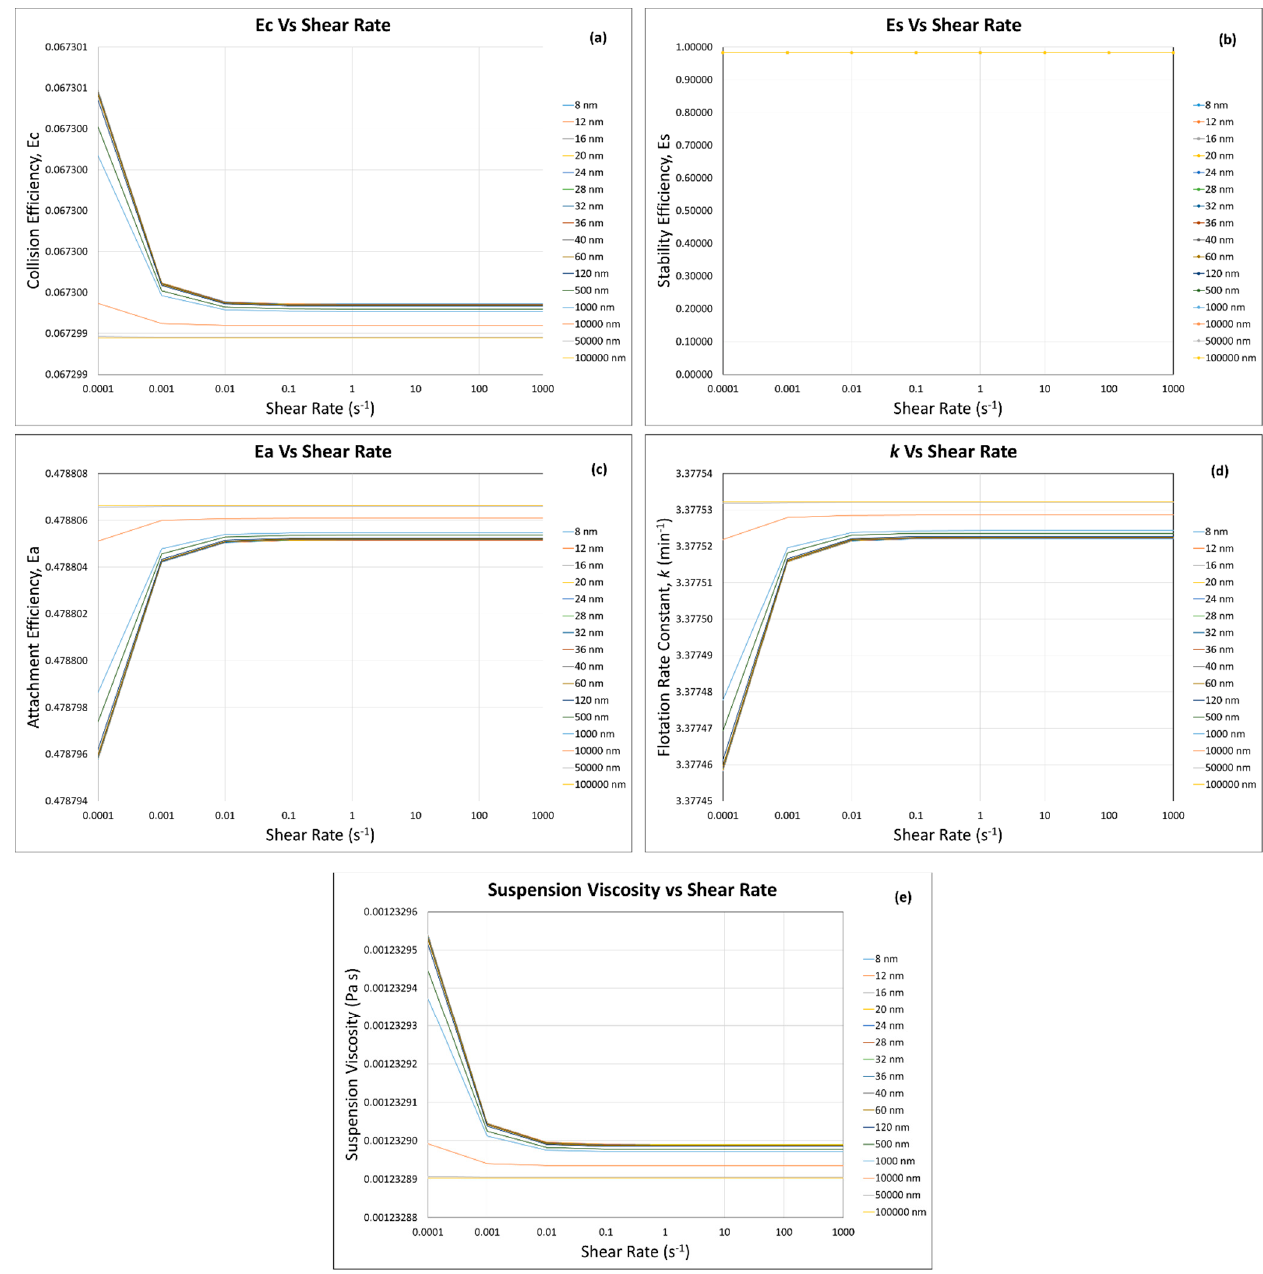
Figure 11. Flotation efficiencies: ( a ) collision, ( b ) stability, ( c ) attachment, and ( d ) rate constant by using ( e ) the suspension viscosity calculated by the predictive model (same particles with different sizes ( 𝑎 (cid:2869) : 𝑎 (cid:2870) = 1: 9 ), at 𝜙 = 0.1 ).